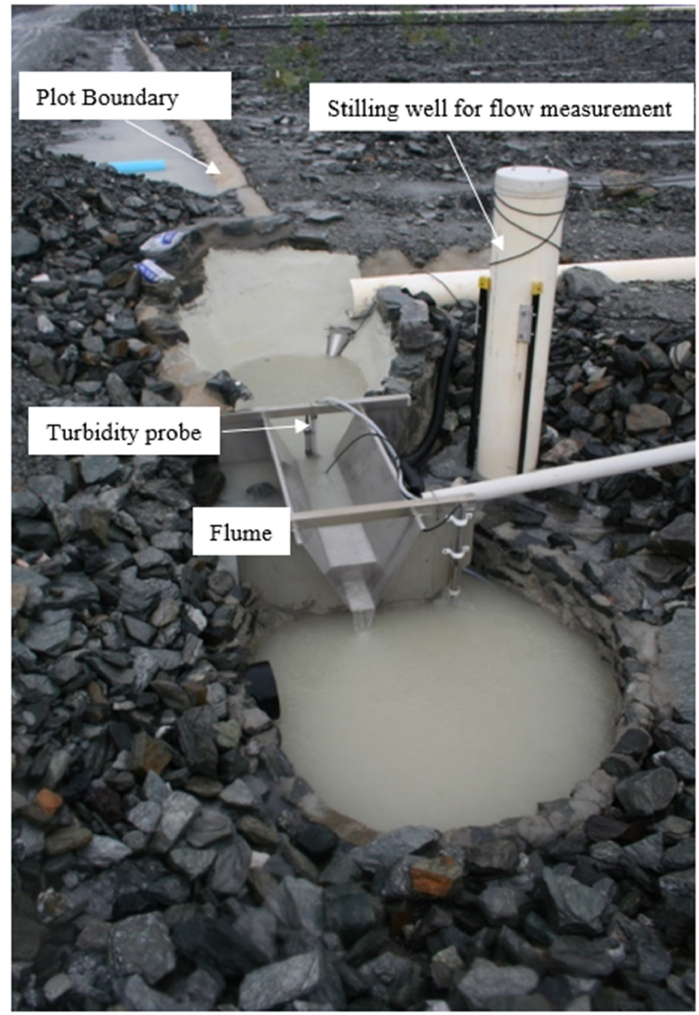
Figure 3. Runoff and turbidity measurement setup [43].